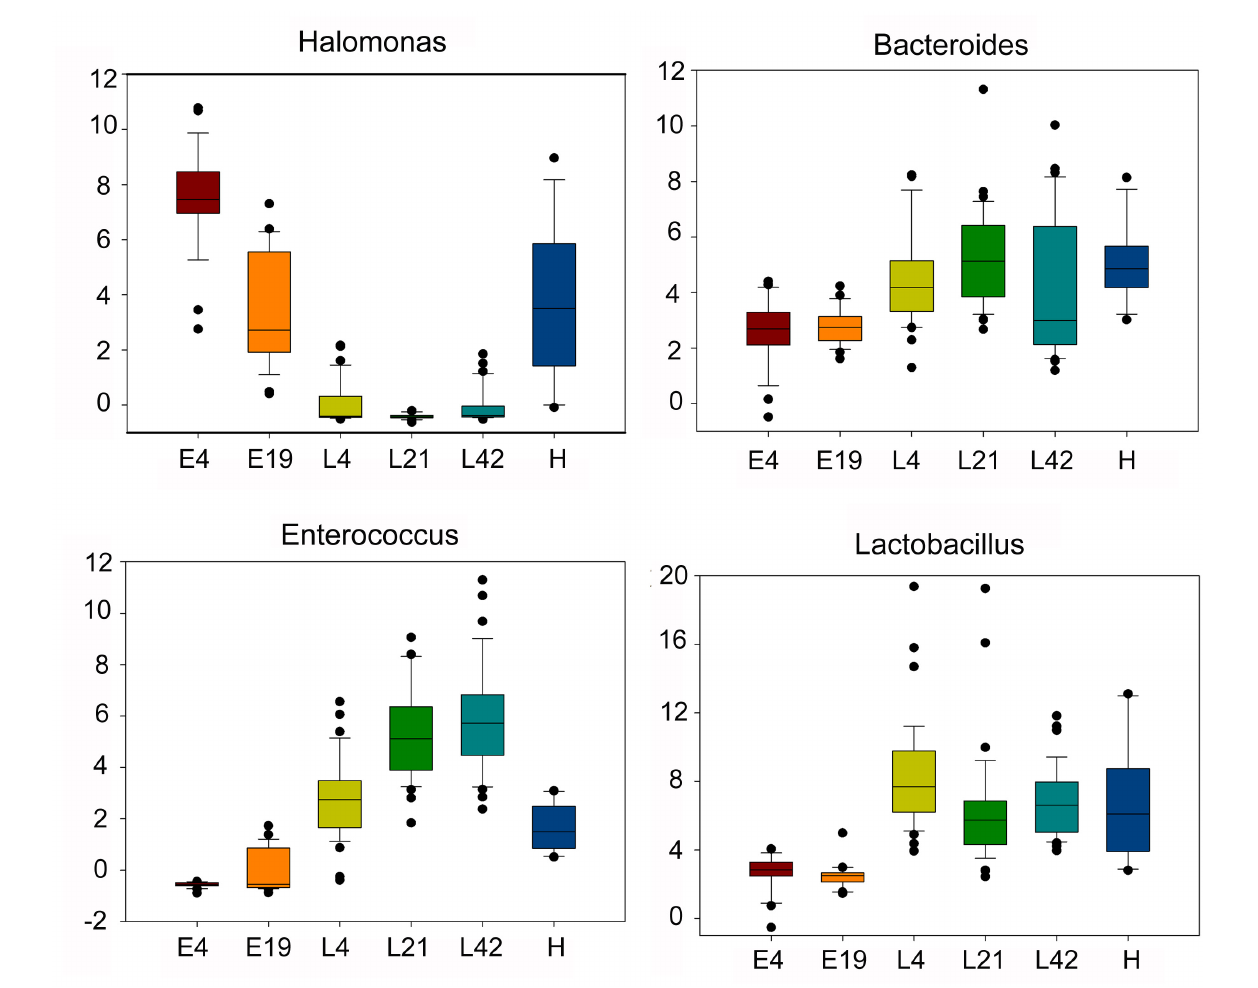
FIGURE 3 | The dynamic distribution of main core microbes within different host development stages including embryos (E) E4 and E19; chicks (L) at 4 (L4), 21 (L21), and 42 days (L42) post hatch; and maternal hens (H) based on microbial abundance. The boxes have lines at the lower quartile, median, and upper quartile